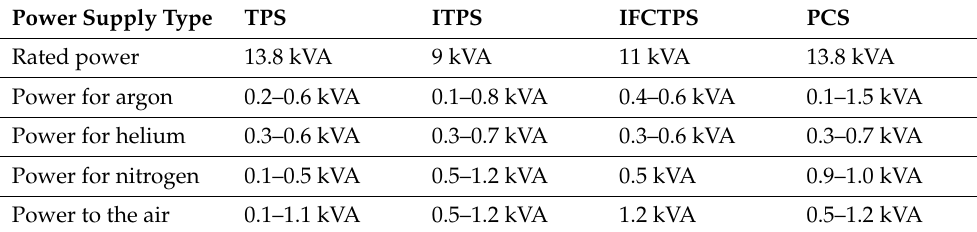
Table 5. Power supply ratings and discharge power ranges for different plasma gases.